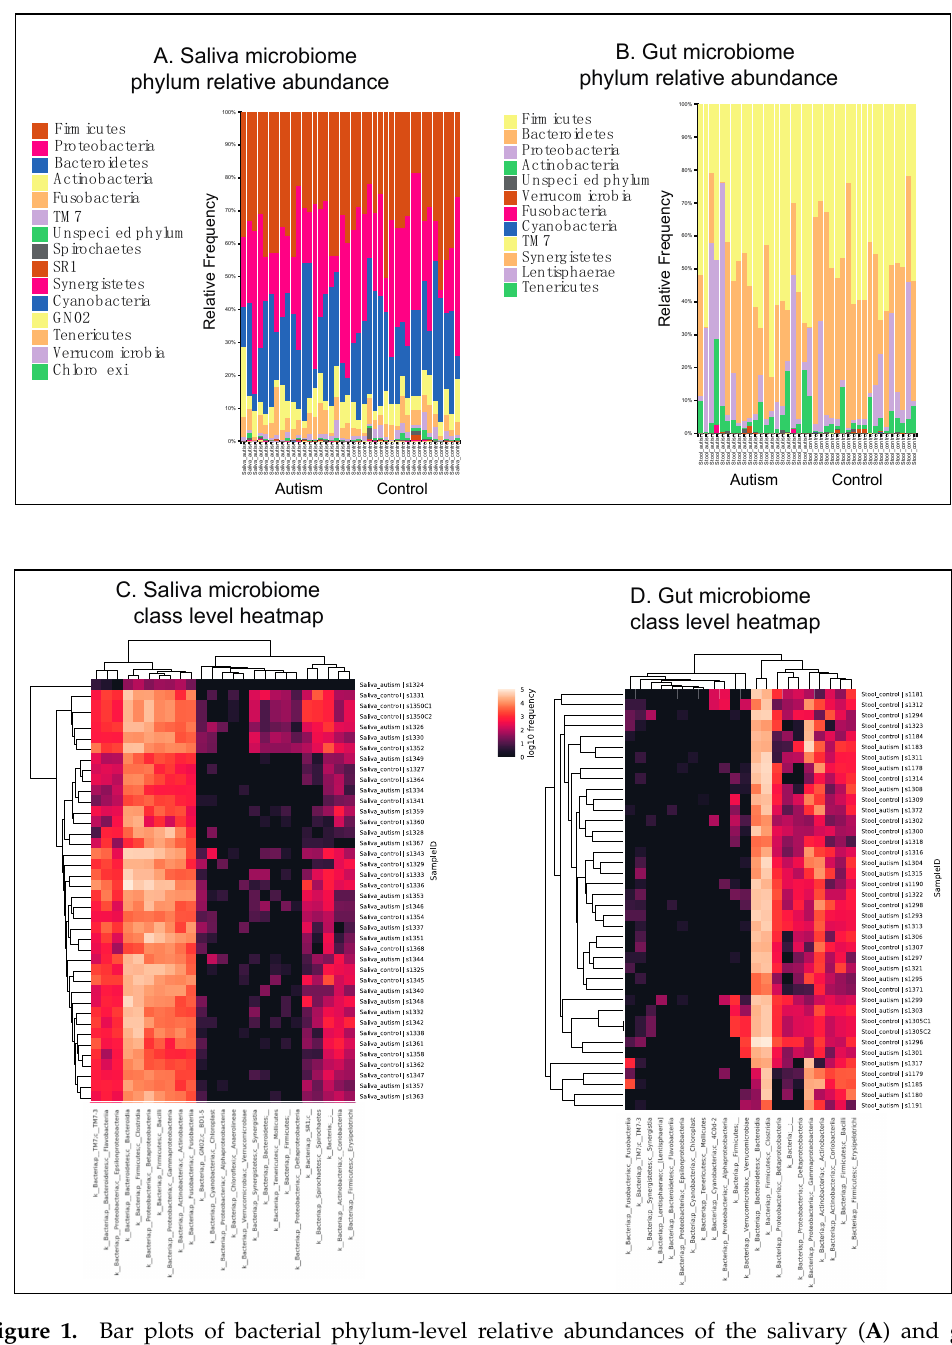
Figure 1. Bar plots of bacterial phylum-level relative abundances of the salivary ( A ) and gut ( B ) microbiomes. Each bar represents one subject. ( C ) Salivary microbiome class-level heatmap expression profile. ( D ) Gut microbiome class-level heatmap expression profile.